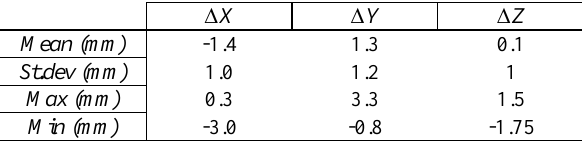
Table 1. Difference statistics on a set of 20 check points.